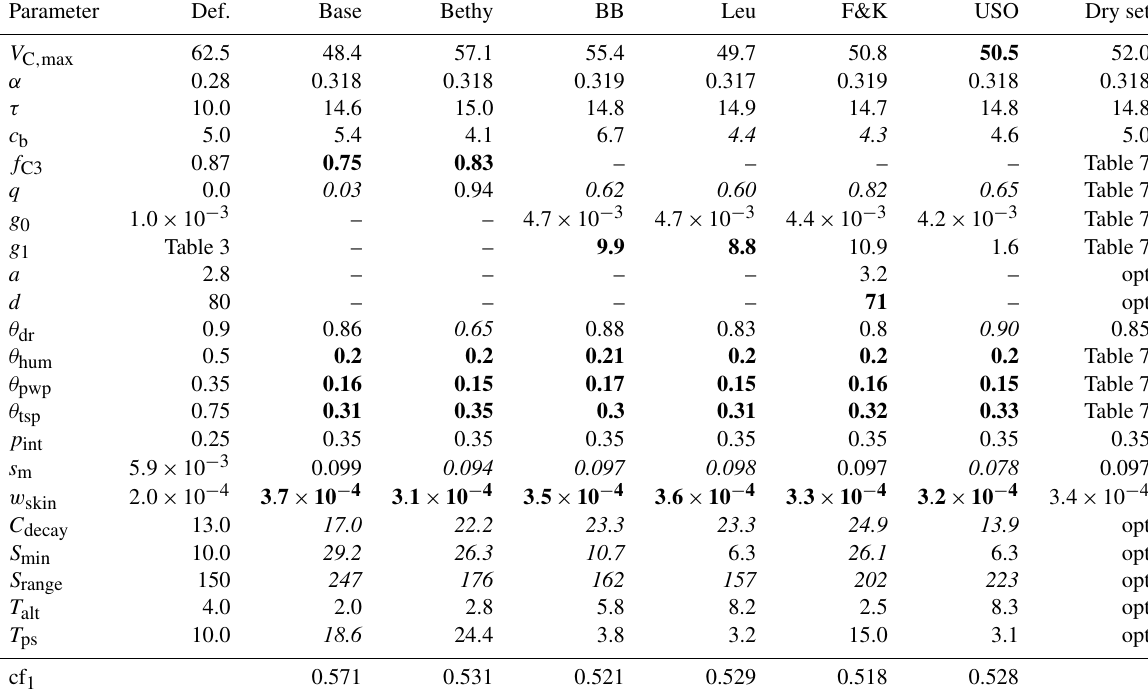
Table 5. Parameter default and optimised values for the calibration period with corresponding cost function value. The values written in boldface were the most effective and the italic values the least effective for the given experiment. Also presented are the fixed parameter values for the drought period optimisation, with “opt” referring to the use of the corresponding optimised value from this table. Parameter